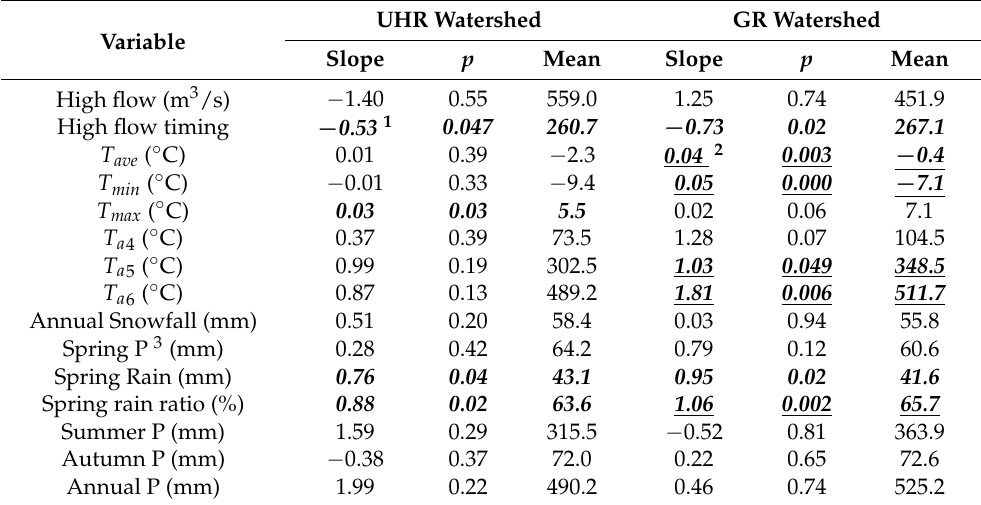
Table 2. Results of Mann–Kendall trend tests on high flow regime components and climatic variables in the UHR and GR watersheds from 1975 to 2013.